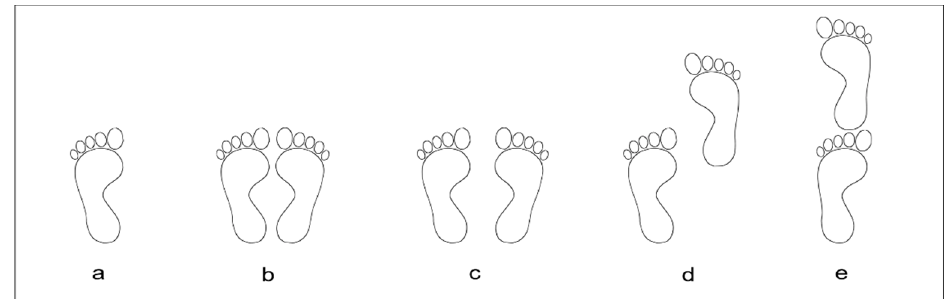
Figure 2. Feet positions: a = Single leg, b = Feet together, c = Feet apart, d = Semi-tandem, e = Tandem3.3.2. Visual Reference